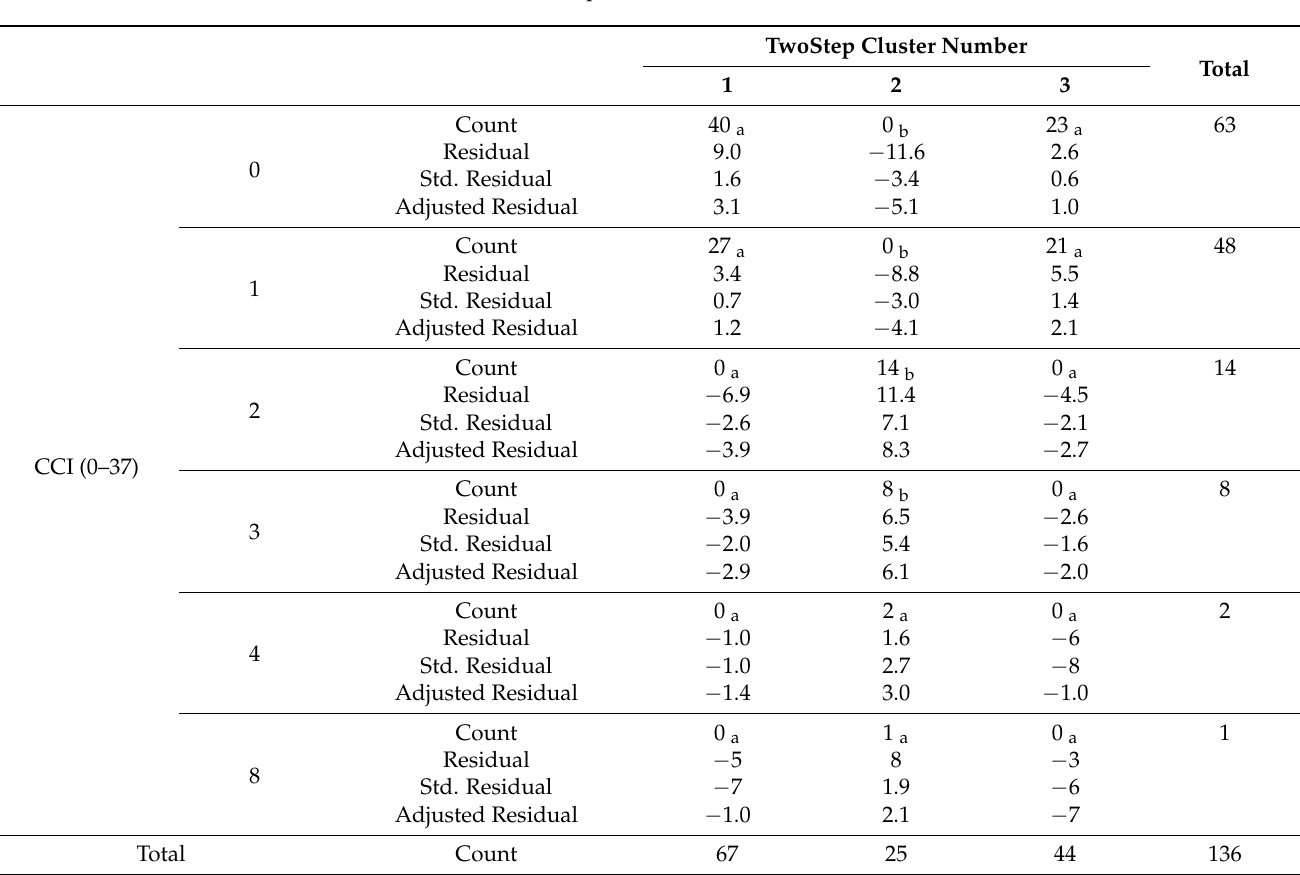
Table 5. CCI (0–37) TwoStep Cluster Number